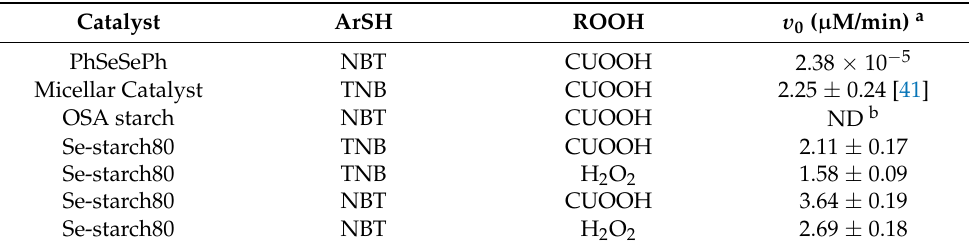
Table 1. The initial rates ( v 0 ) for the reduction of ROOH (250 µ M) by ArSH (150 µ M) in the presence of Se-starch80 at 25 ◦ C and pH 7.0 (50 mM PBS).